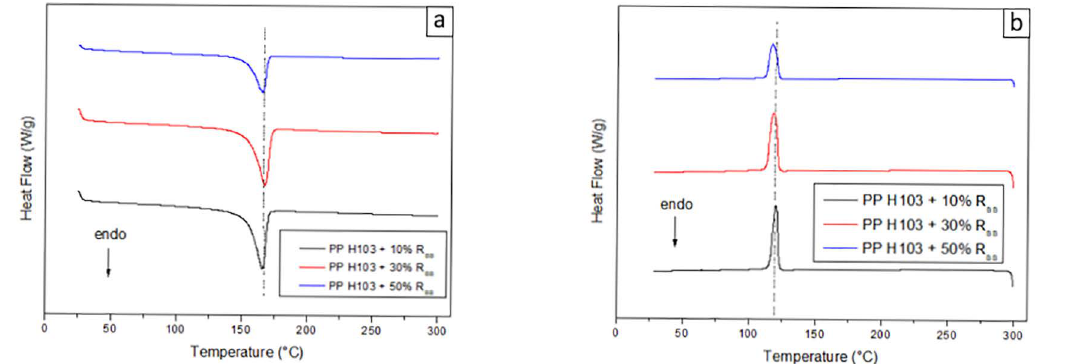
Figure 4. DSC curves of PP H103 compounds acquired during heating (a) and cooling (b) at 10ºC/min.